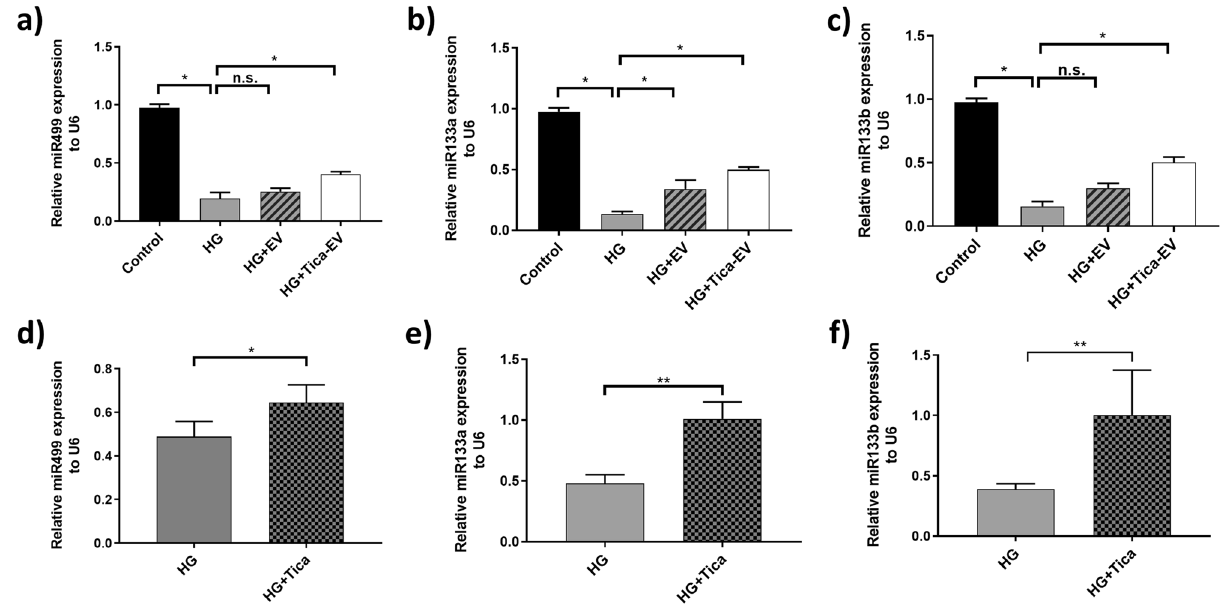
Figure 6. Effects of ticagrelor (Tica, 1 µM) pretreatment on miRNA levels. The mRNA levels of cellular miR- 499 ( a ), miR-133a ( b ), miR-133b ( c ) in HG-H9c2 cells compared to control-EV and Tica-EV treated HG-H9c2 cells. mRNA levels of extracellular vesicular miR-499 ( d ), miR-133a ( e ), miR-133b ( f ) HG-H9c2 cells compared to ticagrelor treated HG-H9c2 cells. Data are expressed as the mean ± SD (n = 4). *p < 0.05, **p < 0.01, n.s.: not